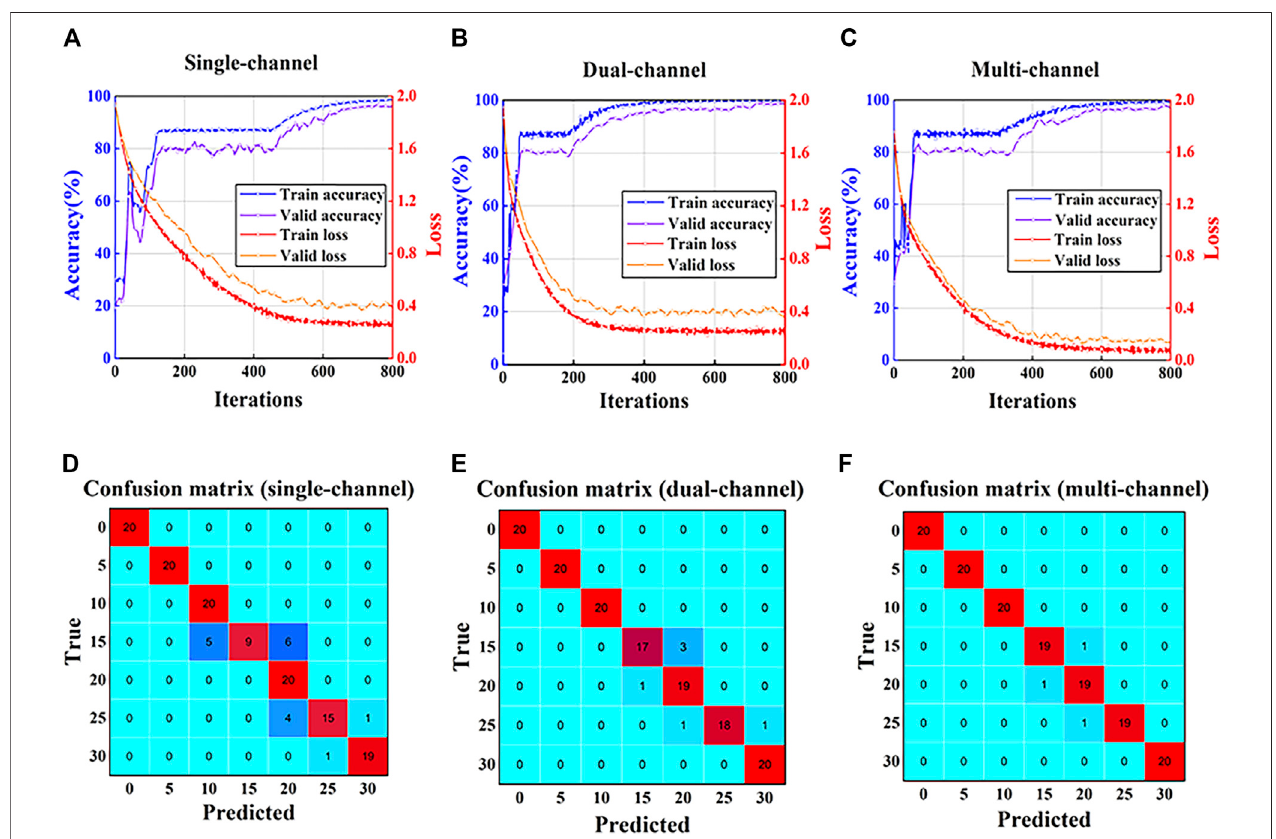
FIGURE13| Training/validationprocessoftheCBAMCNNandtheconfusionmatrixofthetestdataset. (A) Accuracyandlosscurvesofthesingle-channelmethod (PZT2). (B) Accuracy and loss curves of the dual-channel method (PZTs 3 and 4). (C) Accuracy and loss curves of the multichannel method (PZTs 2 – 4). (D) Confusion matrix of the single-channel method (PZT2). (E) Confusion matrix of the dual-channel method (PZTs 3 and 4). (F) Confusion matrix of the multichannel method (PZTs 2 – 4).